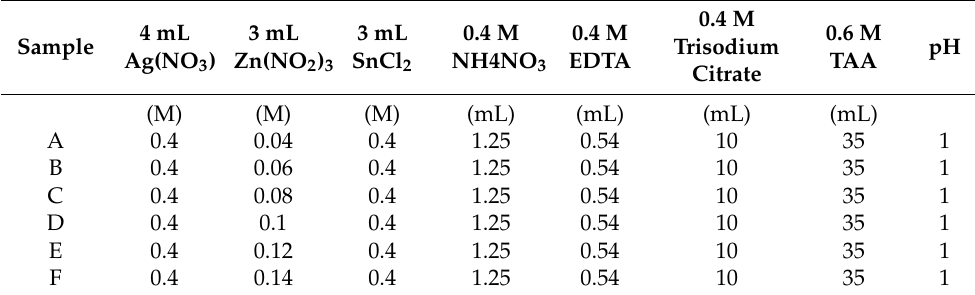
Table 3. Deposition parameters of chemical-bath-synthesized Ag–Zn–Sn–S semiconductor